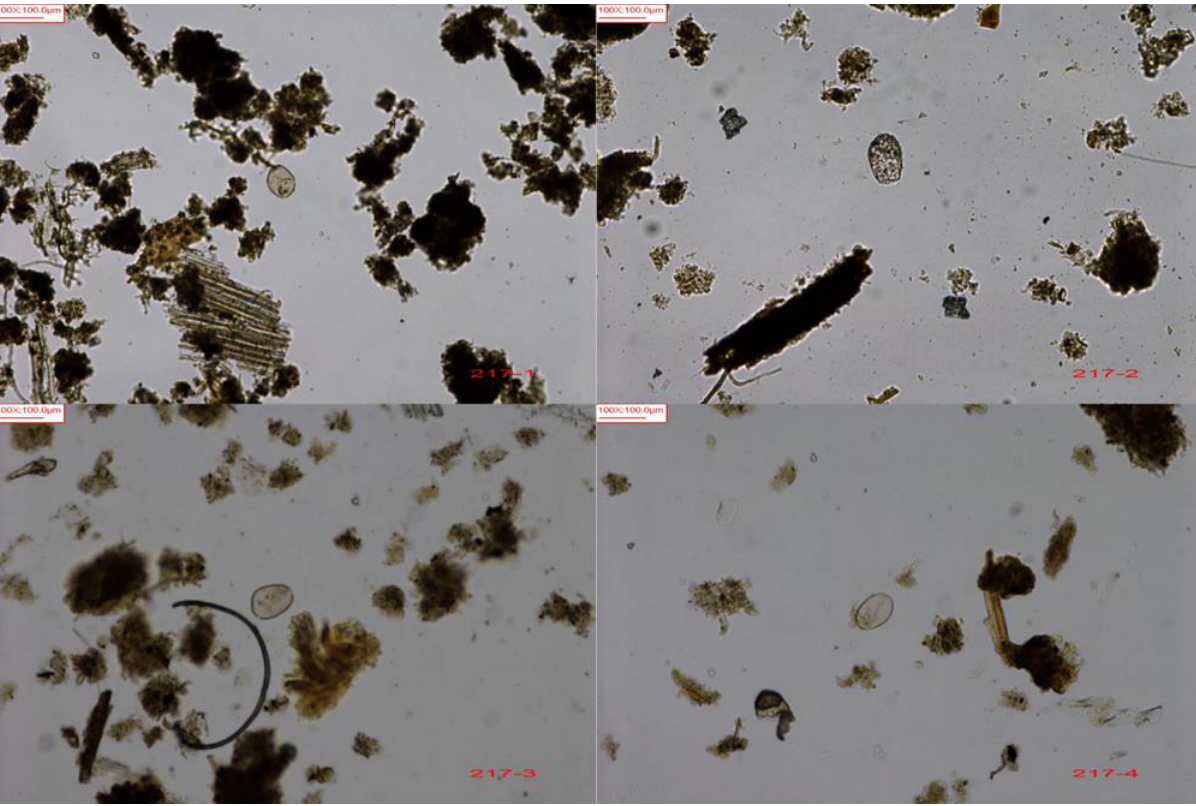
Figure 4. Microscope slide clarity of samples from depth 270 cm with the four different treatments under 100× magnification. Table 2. Pairwise, multivariate ANOVA